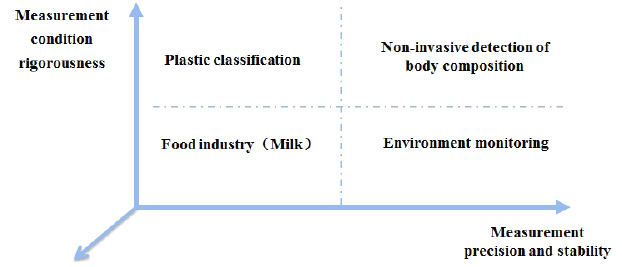
Fig. 1. Requirements in di®erent ¯elds of NIR noninvasive